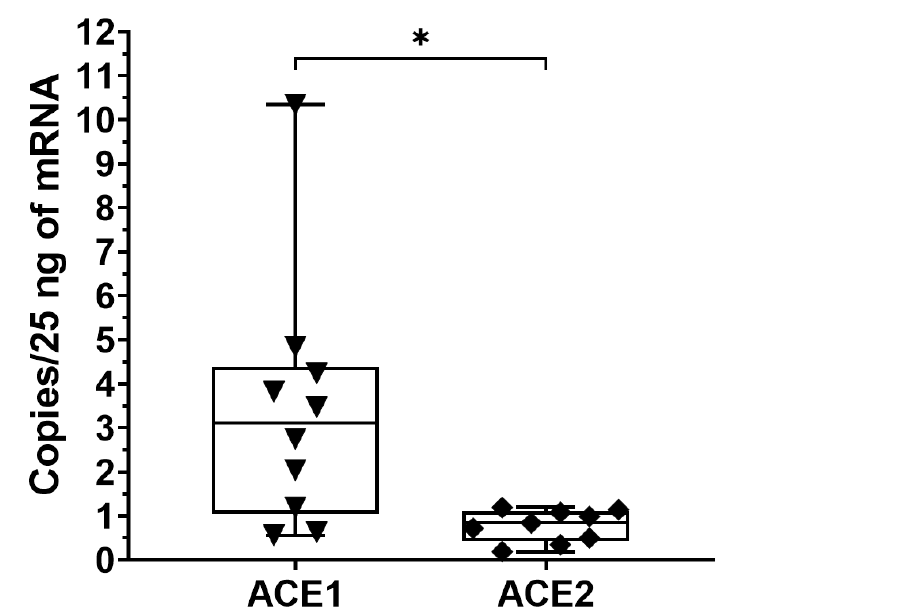
Figure 6. Gene expression of ACE2 and ACE1 in human thoracolumbar fascia. ACE1 and ACE2 expressions were investigated with ddPCR. Both enzymes were expressed at low levels ( ACE1 : 3.38 ± 2.86 copies/25 ng of mRNA; ACE2 : 0.77 ± 0.36 copies/25 ng of mRNA, respectively); *: p < 0.05.